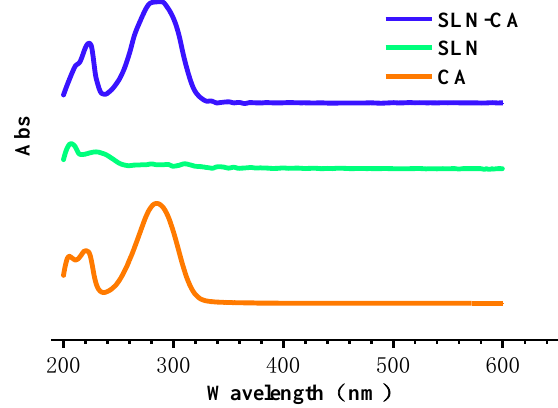
Figure 6. CA, SLN and SLN-CA of UV absorption spectrum.